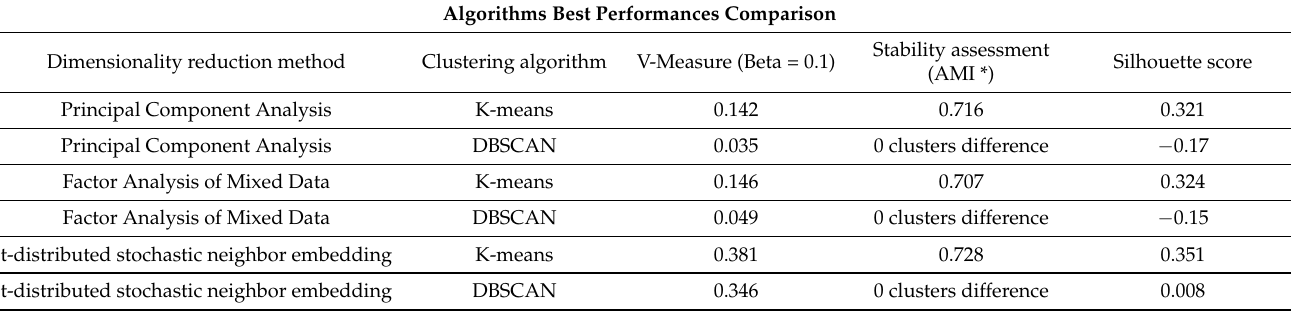
Table 6. Performance